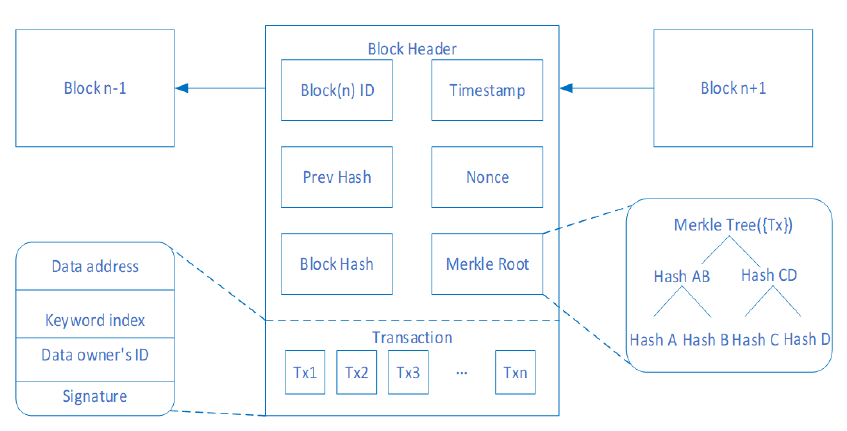
Figure 1. Block structure reconstruction diagram.